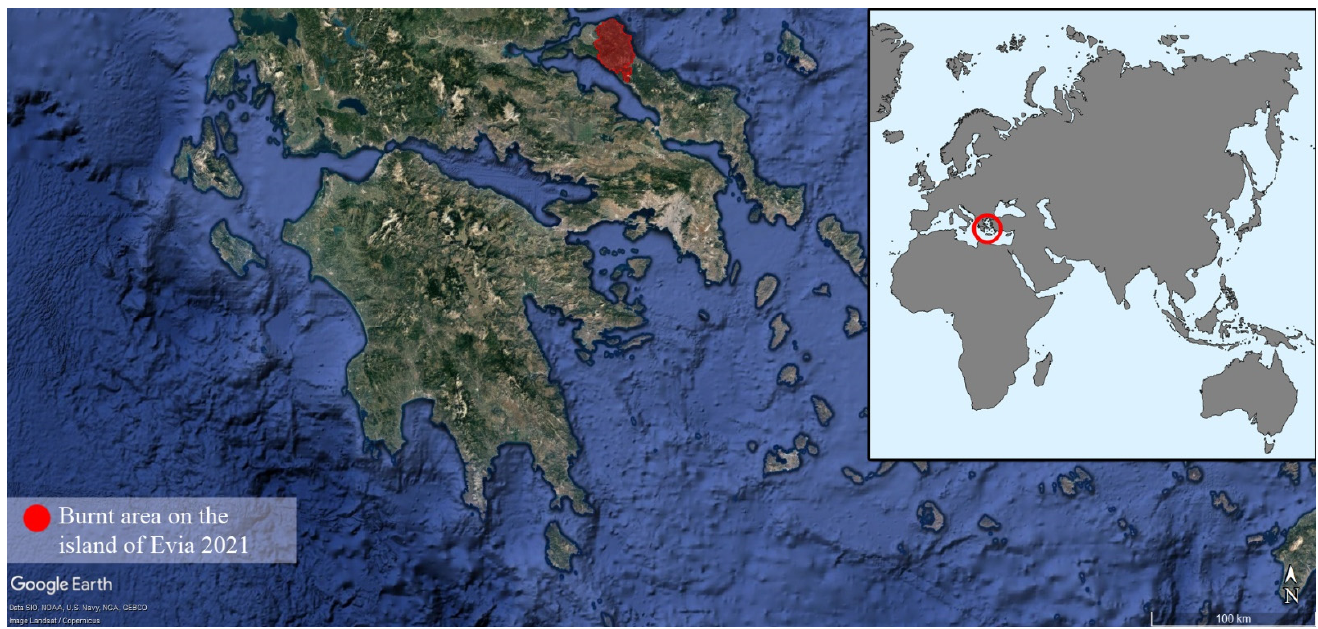
Figure 7. Burnt area on the island of Euboea 2021 [73].